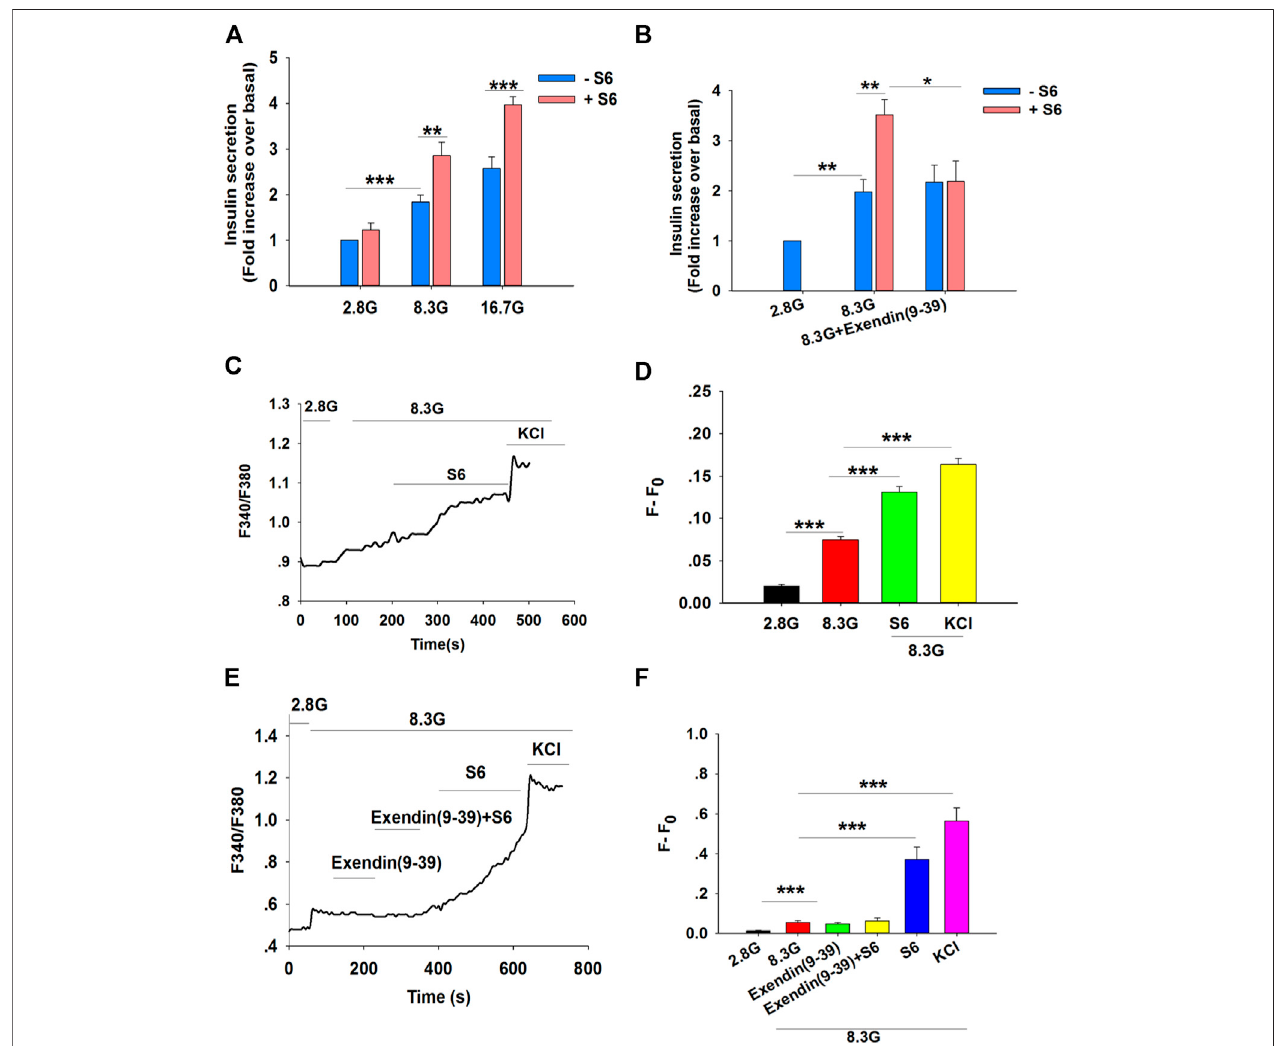
FIGURE3| S6stimulatesinsulinsecretionand[Ca 2+ ] i levelsbyactivatingtheGLP-1R. (A) TheeffectofS6oninsulinsecretionfromratisletsunderdifferentglucose conditions. Islets were treated with 10 μ M S6 under 2.8 mM glucose (2.8 G), 8.3 mM glucose (8.3 G) and 16.7 mM glucose (16.7 G) conditions. Data are expressed as the mean ± SEMand compared byone-wayANOVA.n (cid:2) 7,** p < 0.01, *** p < 0.001. (B) Effect ofExendin (9-39) onS6-inducedinsulin secretion.Islets wereexposedto 10 μ M S6 in the presence or absence of Exendin (9-39) (100 nM). Data are expressed as the mean ± SEM and compared by one-way ANOVA. n (cid:2) 6, * p < 0.05, ** p < 0.01.Alldataarenormalizedtobasalsecretionat2.8 G. (C) EffectofS6on[Ca 2+ ] i inthepresenceof8.3 Gin β cells.Thechangesin[Ca 2+ ] i wereplottedbytheratio of 340/380 nm fl uorescence. (D) The mean value of F-F 0 in response to S6 as indicated (F: the fl uorescence mean value within 30 s (15 s before and after the peak of F340/F380) after different treatments; F 0 : the fl uorescence mean value within 30 s (15 s before and after the nadir of F340/F380) for 2.8 G). KCl (60 mM) was used as positive control. Data are expressed as the mean ± SEM and compared by one-way ANOVA. n (cid:2) 13, *** p < 0.001. (E) Effect of Exendin (9-39) on S6-induced [Ca 2+ ] i in the presence of 8.3 G. The changes in [Ca 2+ ] i were plotted by the ratio of 340/380 nm fl uorescence under different interventions. (F) The average value of F-F 0 in response to S6 in the presence or absence of Exendin (9-39) as indicated. KCl (60 mM) was used as positive control. Data are expressed as the mean ± SEM and compared by one-way ANOVA. n (cid:2) 8, *** p <